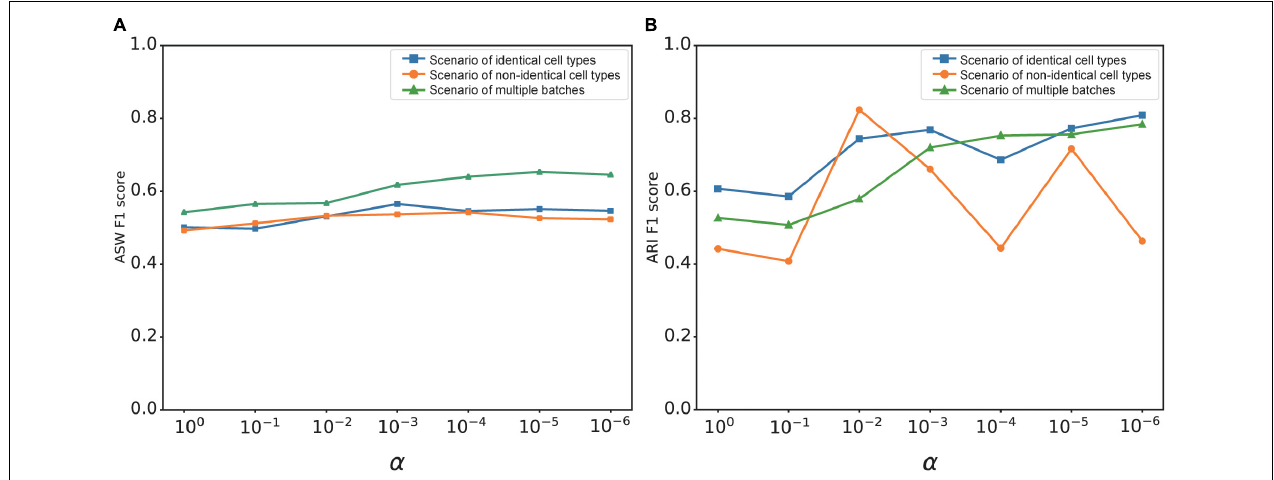
FIGURE 7 | The effect of value changes in α on the batch correction performance of deepMNN under three scenarios of identical cell types, non-identical cell types, and multiple batches. (A) The ASW F1 scores versus various α values under different scenarios. (B) The ARI F1 scores versus various α values under different